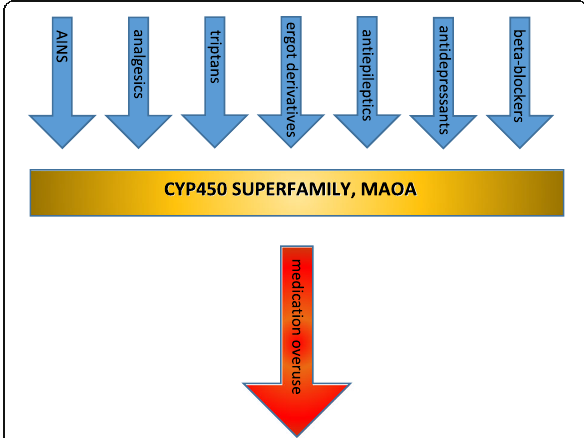
Fig. 2 Drug-drug interactions between preventative and acute migraine medications. The reported classes of drugs compete for the same metabolic pathway, and this represents the most common causes of drug reduction of efficacy and/or toxicity (for details please refer to ref. [23], specifically to tables 1 and 2), leading to medication overuse. Legenda AINS: anti-inflammatory non-steroidal drugs; CYP450: cytochromes P450 (accounting for the metabolism of more than 70% of prescribed drugs); MAOA: